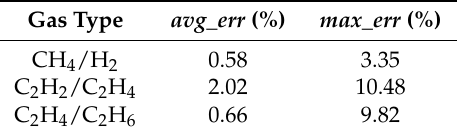
Table 4. NAR–DWT prediction error for gas concentrations ratios.